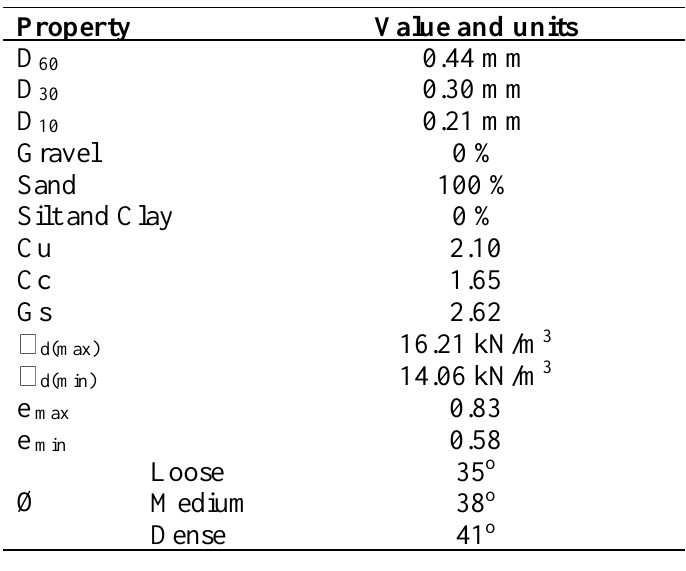
Table 1. Mechanical and physical properties of the used